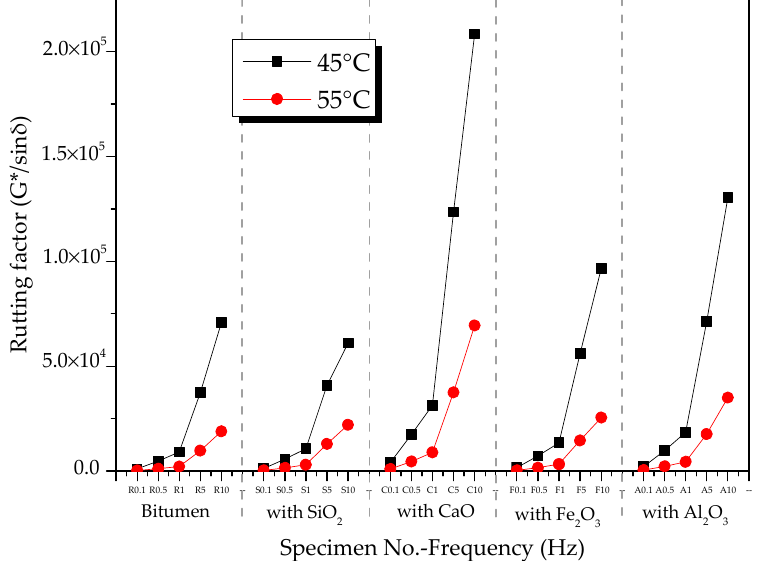
Figure 7. Effects of temperature on rutting factors of oxide-modified bitumen mixtures.